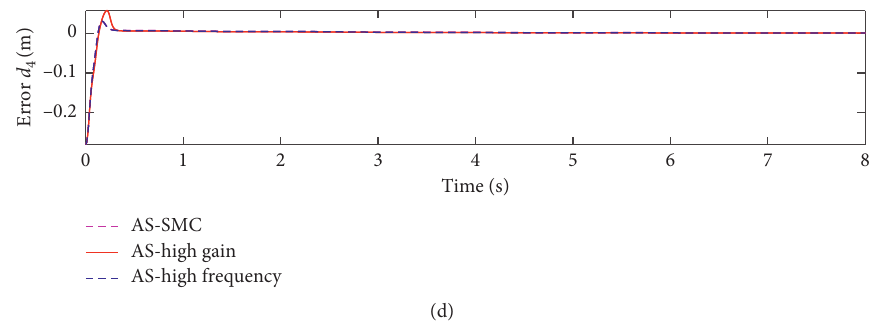
Figure 12: The position errors of actuator joints.